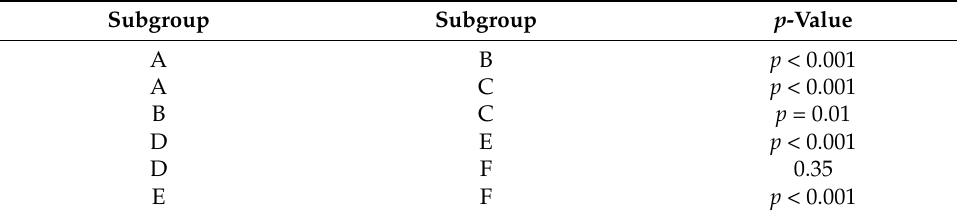
Figure 3. Mean SBS of the Panavia and MHA cements in different surface treatments. Table 3. Post hoc Tukey’s multiple comparison test between groups for SBS.